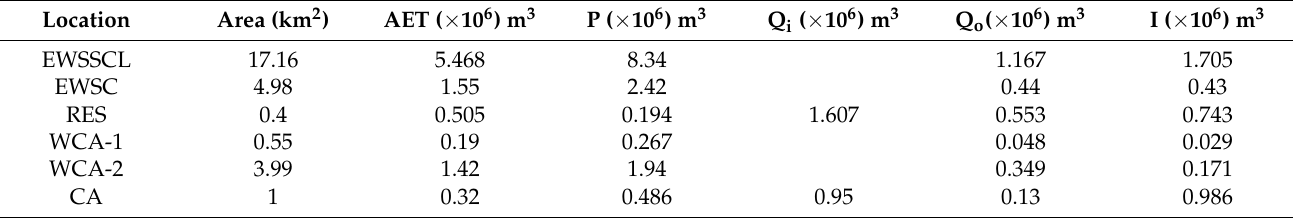
Table 1. Summary of water balance based on soil type of the